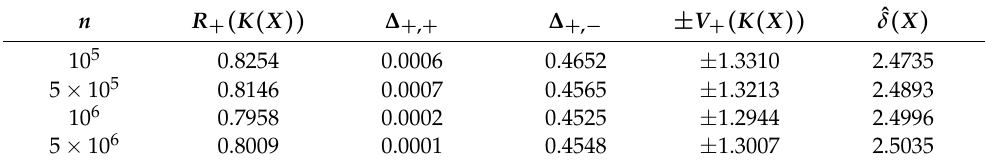
Table 5. Examples of estimates for the parameters of the model distribution GE ( 0.8;1.3;0.3;1.4;2.5 ) .